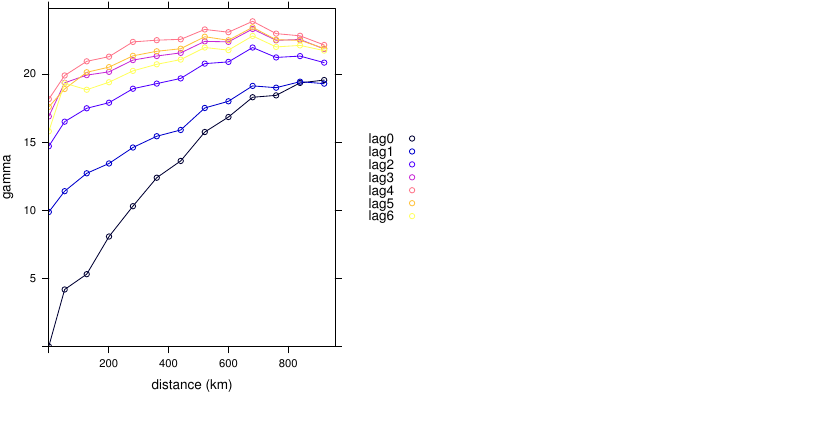
Figure 6. Classical semivariograms of the daily Tmax from the NOAA data with respect to the seven time lags considered.